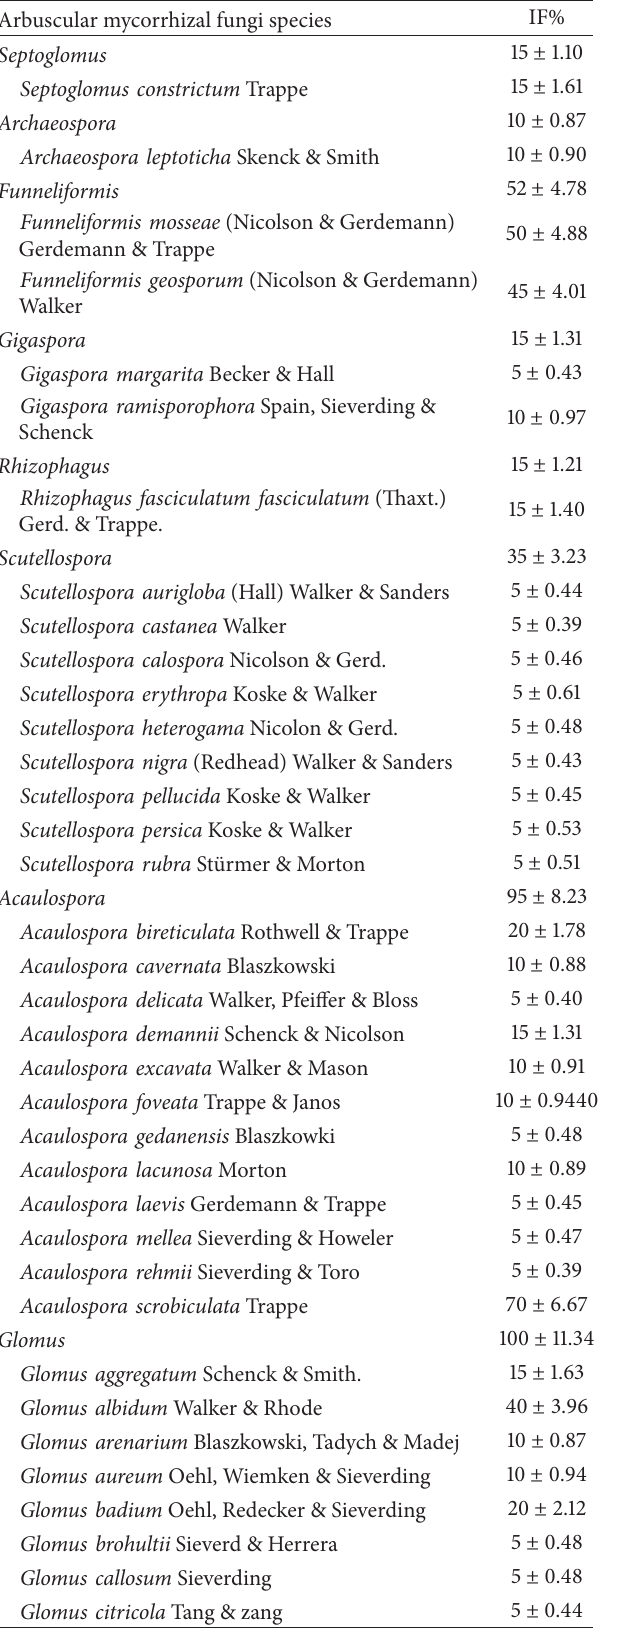
Table 4: Isolation frequency (IF) of AM